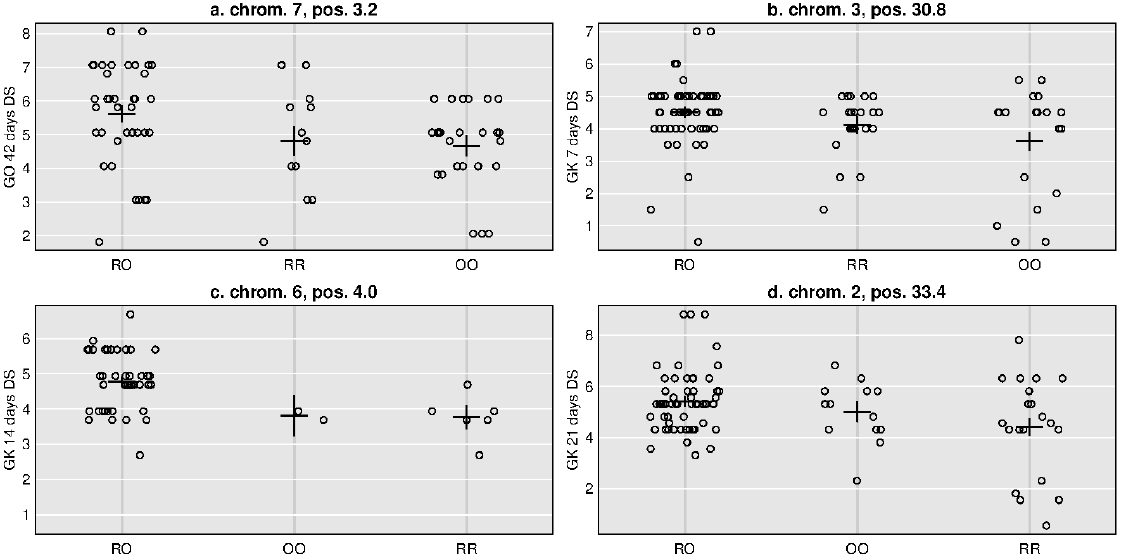
Figure 4. Phenotype × genotype plots for Ascochyta disease scores at various periods after inocula- tion representing the four quantitative trait loci (QTLs) found in two chickpeas Gokce × Oyali and Gokce × Karab families. Each figure panel is named according to QTL chromosome and Mbp posi- tion. The x-axis shows genotypes made up of cultivated reference (R) or wild other (O) alleles. Cir-